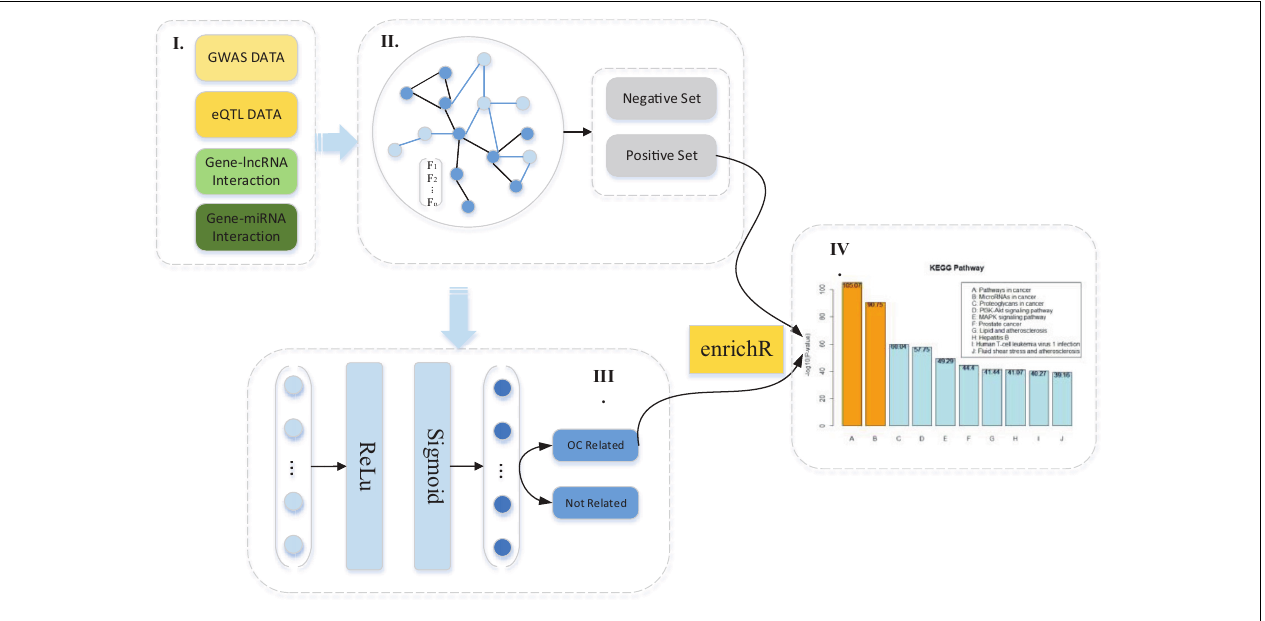
FIGURE 1 | The pipeline of ovarian cancer (OC) causal gene prediction method.